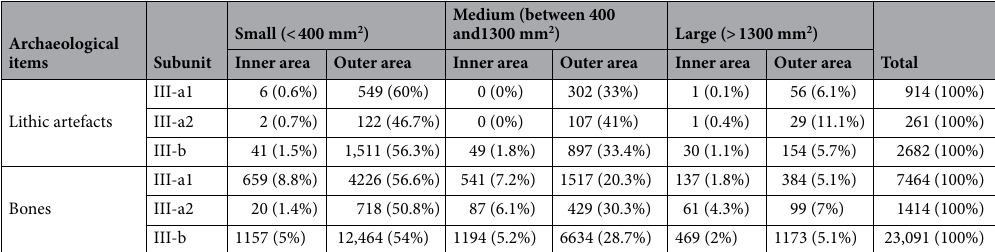
Table 6. Frequency and proportion of lithic artefacts and bone remains according to size categories and their location in Chamber X.